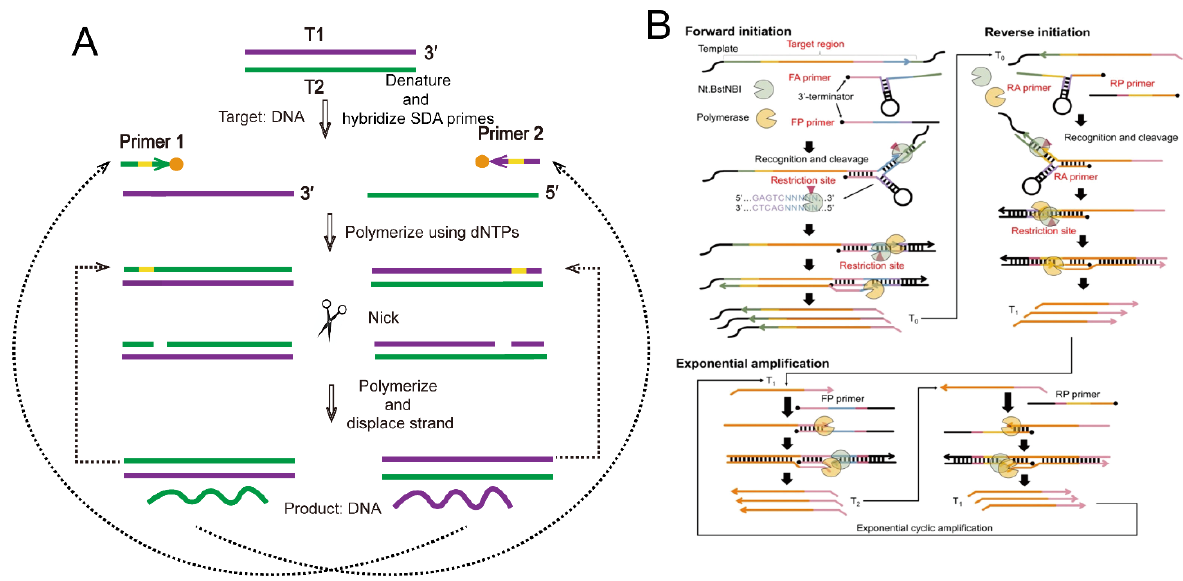
Figure 3. ( A ) Basic principle of nicking enzymes combined with SDA. ( B ) Example of nicking enzyme combined with SDA to detect RNA. (Reprinted with permission from Ref. [66]. Copyright 2021 American Chemical